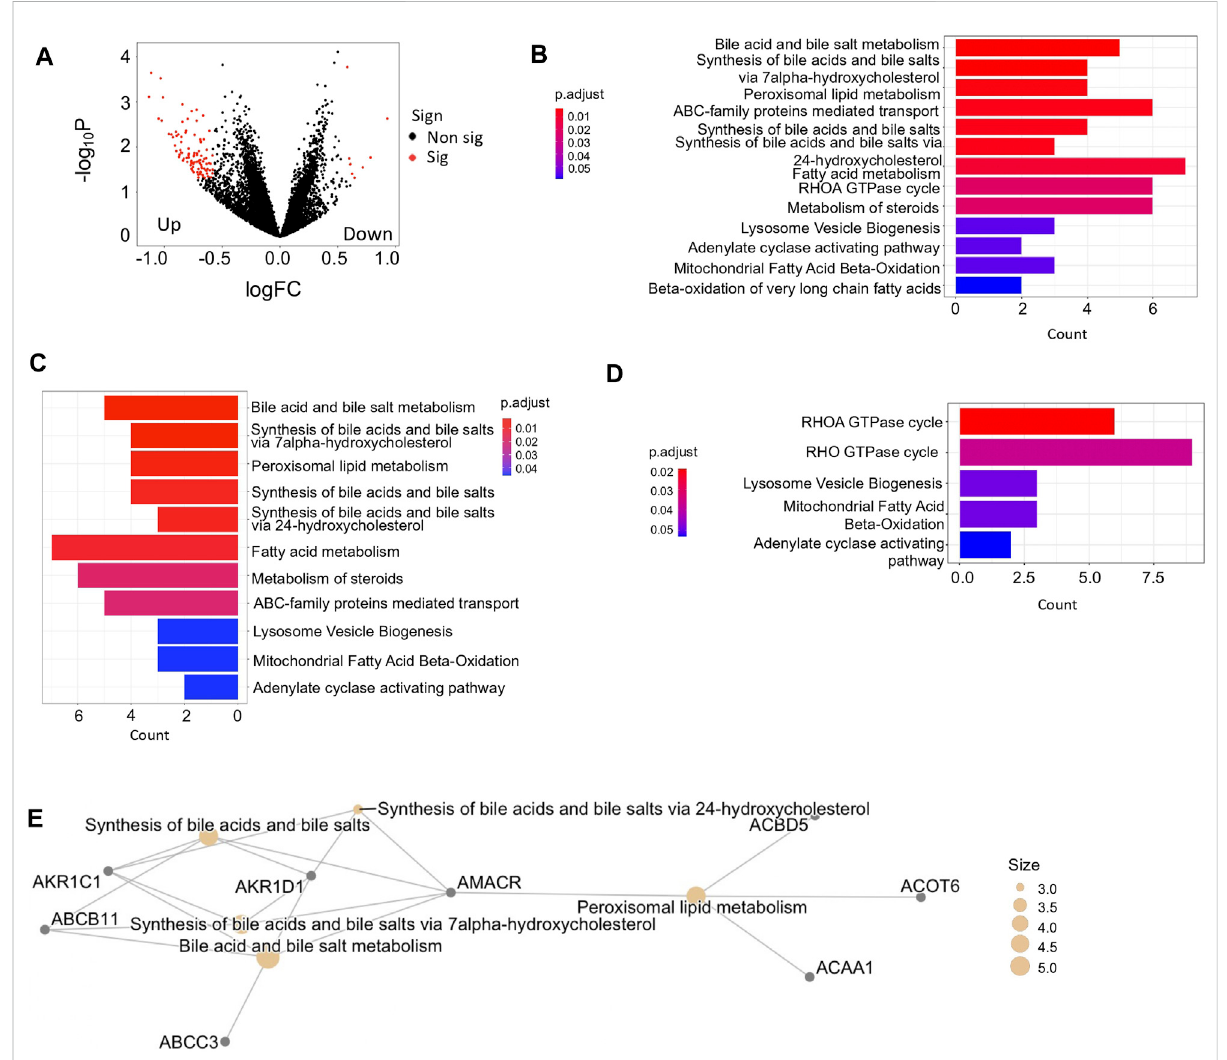
FIGURE 3 Analysisofcodinggeneexpressionbetweenvariantandnon-variantHCCs. (A) VolcanoplotofDEGs.logFC < 0representsupregulatedgenesin variant HCCs compared with non-variant HCCs. Red color represents the dots pass the fi ltering criteria i.e., |logFC| < 0.5 and -log10p > 1. (B) Bar plot enriched biological processes with -log10p > 1 by databases of Reactome between variant and non-variant HCCs. (C,D) Bar plot of enriched pathways of upregulated genes (C) and downregulated genes (D) in variant HCCs compared with non-variant HCCs. (E) The pathway network of top 5 enriched pathways enriched by upregulated genes in variant HCCs compared with non-variant